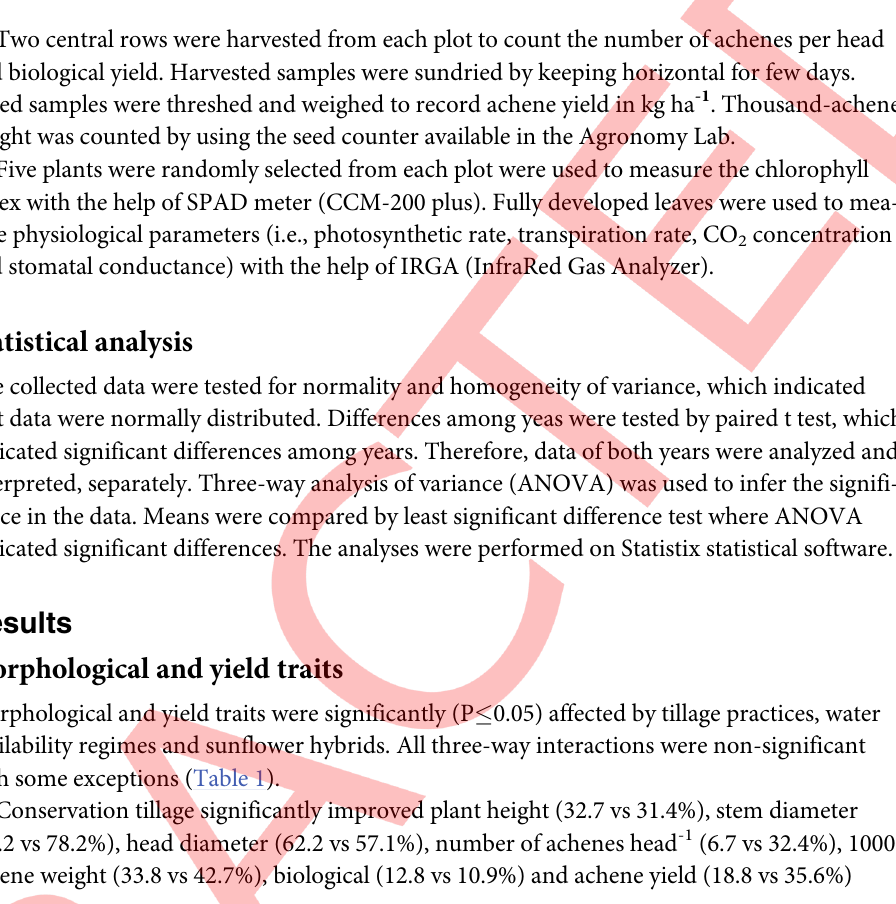
Table 1. Analysis of variance (ANOVA) of morphological and yield-related traits of sunflower hybrids as influenced by various tillage practices and water availabil- ity regimes. Source df Mean square plant